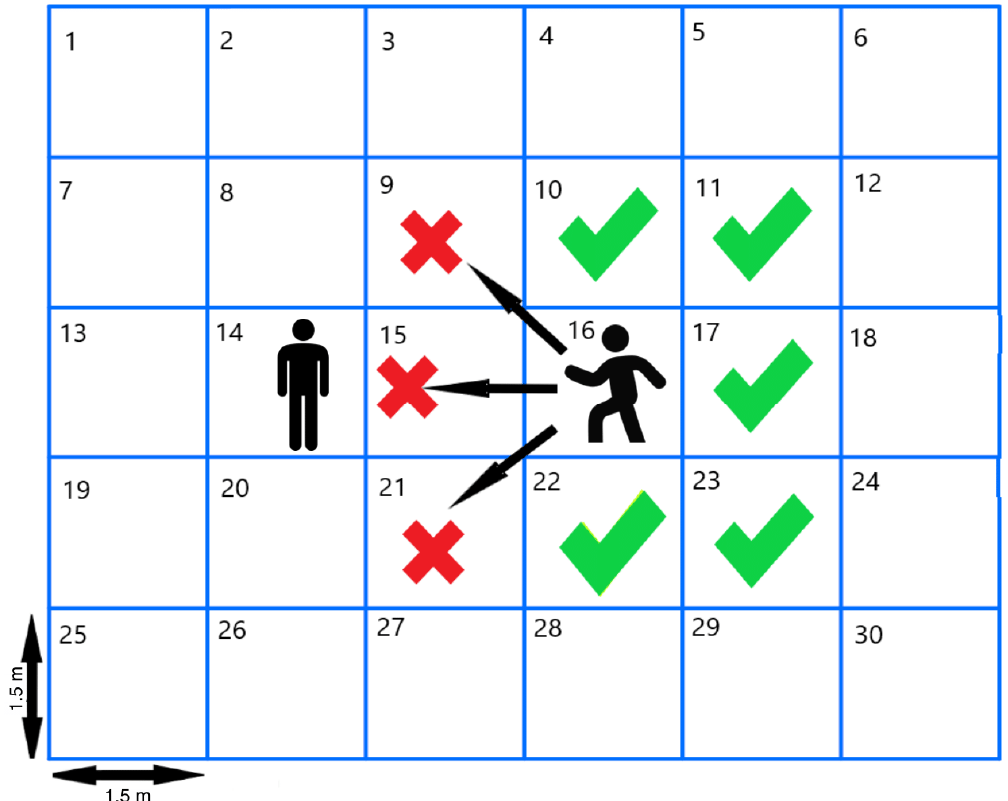
Figure 5. Markings on the floor to maintain a safe distance; the red cross indicates areas that should be avoided and the green check indicates possible areas to walk.